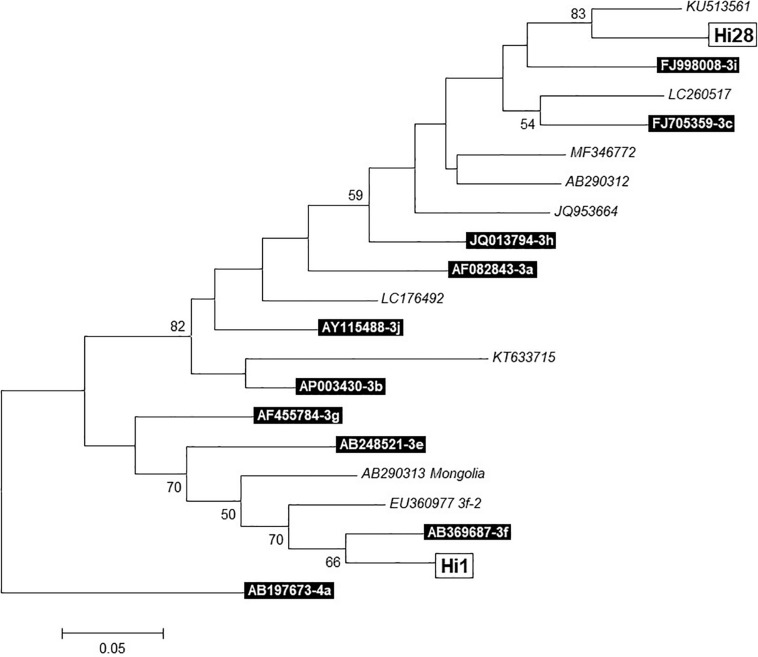
Phylogenetic tree of two sequences (Hi1 and Hi28) obtained from liver samples. Built with MEGA 7.0.